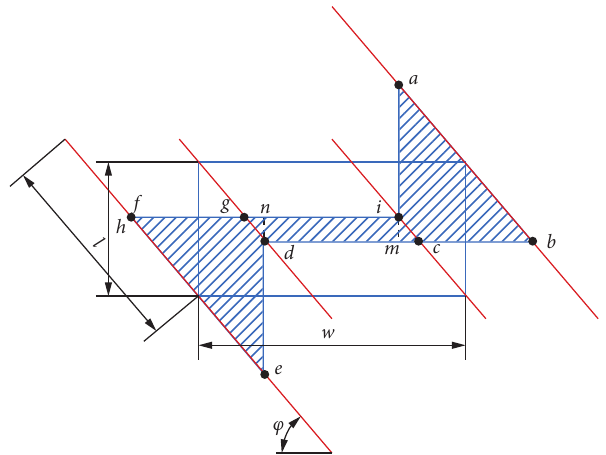
Figure 6: Discontinuities with both ends censored, l ≥ ( h /sin φ ) and φ ≥ tan − 1 ( h / w ) .